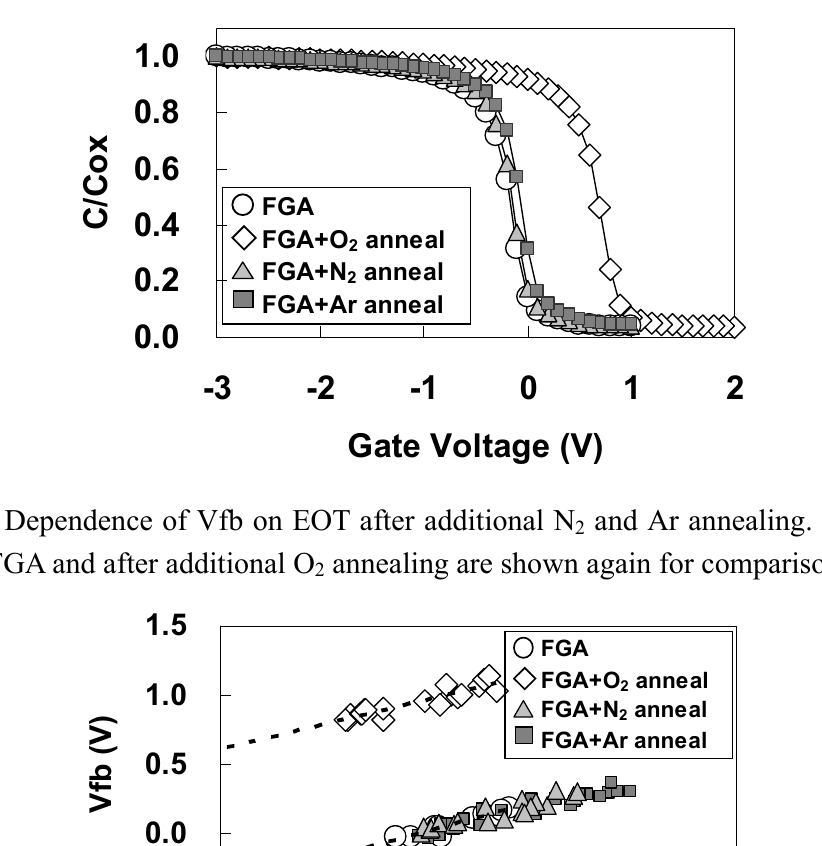
Figure 23. C-V curves for the highest capacitances after additional N curves after only FGA and after additional O